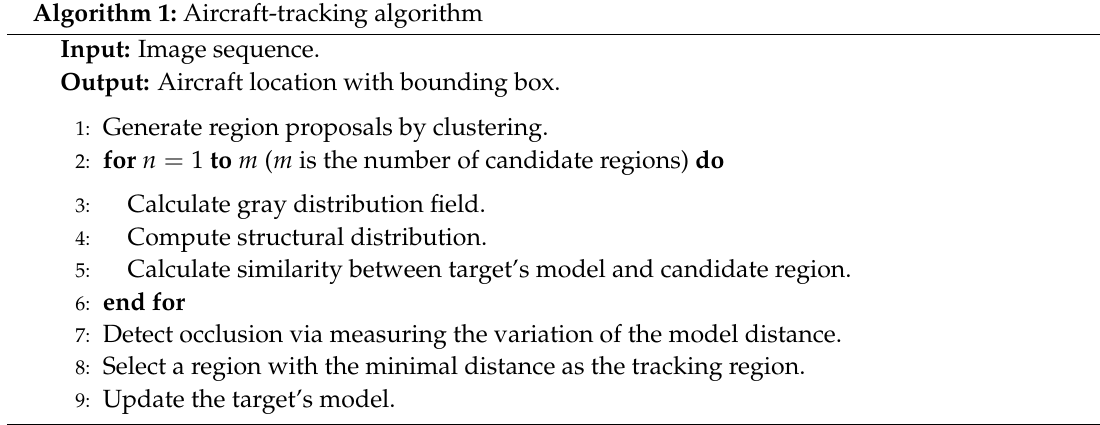
Algorithm 1: Aircraft-tracking